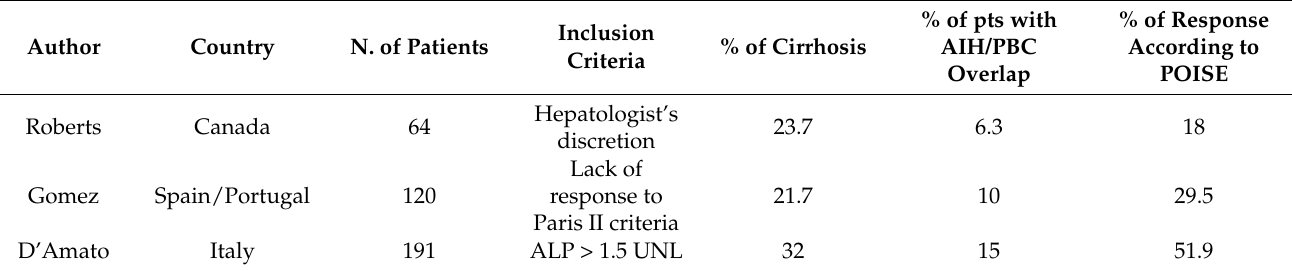
Table 3. Real-world data in three cohorts of patients with